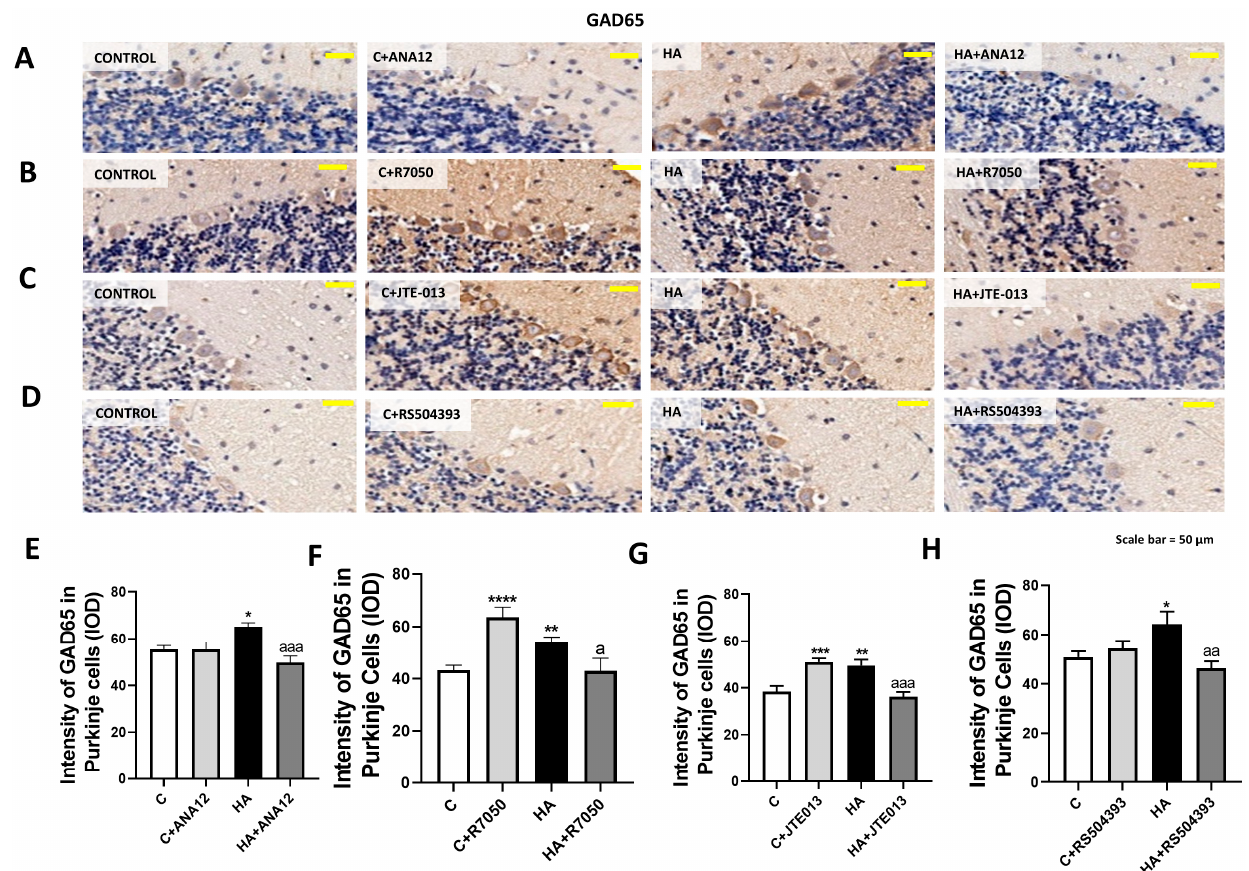
Figure 4. GAD65 content increased in the Purkinje neurons of hyperammonemic rats. Ex vivo treatment with ANA12, R7050, JTE-013, or RS504393 reversed this increase. ( A – D ) Immunohistochemistry was performed as indicated in Section 4 with DAB staining using antibodies against GAD65. Representative images are shown. ( E – H ) GAD67 content was quantified in Purkinje cells as described in Section 4. Values are the mean ± SEM of 8 rats per group. Values significantly different from control rats are indicated with asterisks, and from hyperammonemic rats are indicated by “a”. * p < 0.05, ** p < 0.01, *** p < 0.001; **** p < 0.0001; a p < 0.05, aa p < 0.01, aaa p < 0.001. ( E – H ) F values